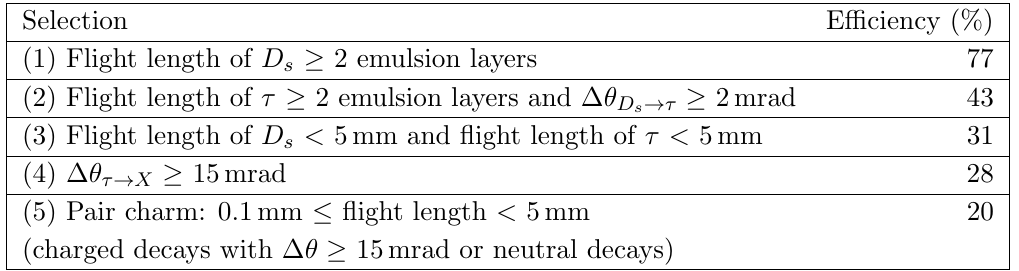
Table 1 . Breakdown of the e(cid:14)ciency estimation for D s ! (cid:28) ! 1-prong decay. (1) is to measure direction of D s mesons with a required precision, (2) to measure angles of (cid:28) and to detect kinks larger than 4 standard deviations of angular measurement, (3) to suppress the background, especially hadron interaction background, (4) to detect (cid:28) decays by the fast scanning system, and (5) to suppress the backgrounds and to detect decay topology of pair charm by the fast scanning system.